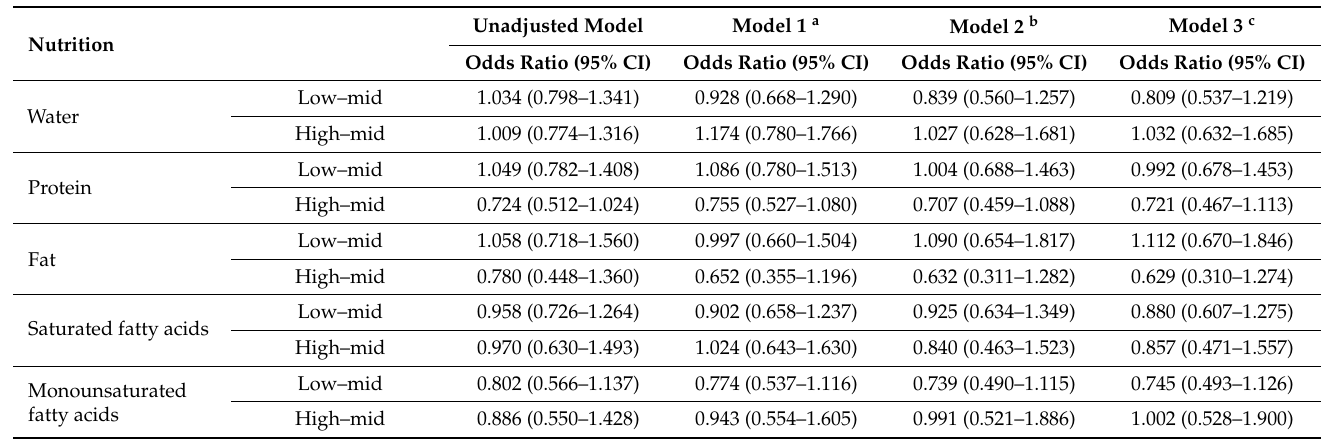
Table 3. Results of univariate multiple logistic regression analysis on the association between nutrient intake and cataracts for each model according to adjustment variables in the female group. Each nutrient intake significantly associated with cataracts in the univariate simple logistic regression was used as an independent